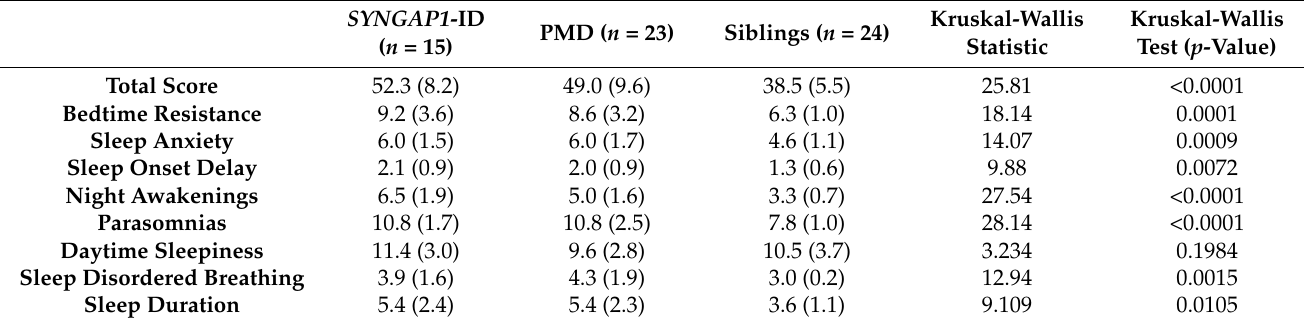
Table 4. CSHQ data 11 years and older, mean (standard